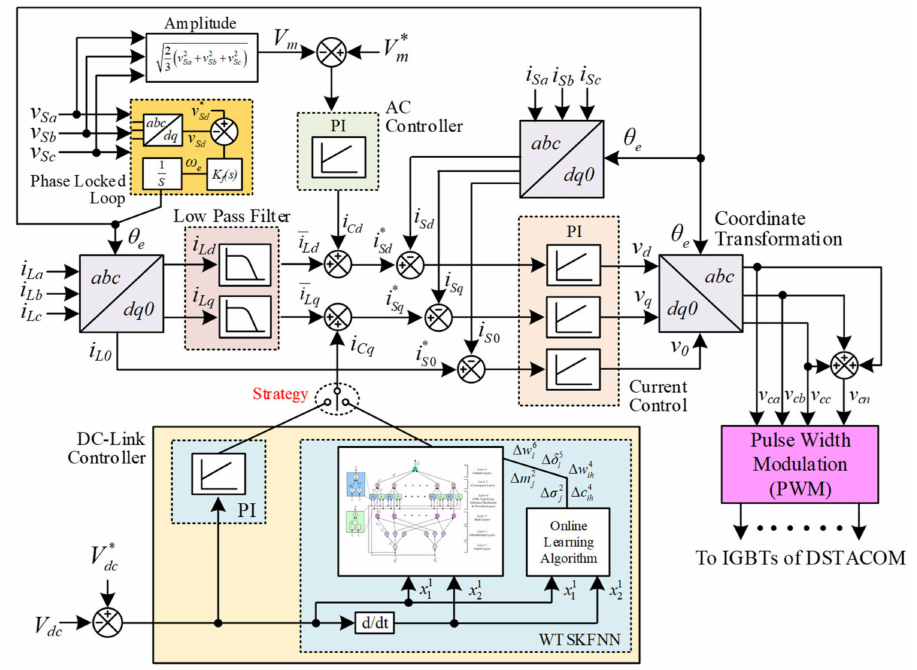
Figure 2. Control block diagram of